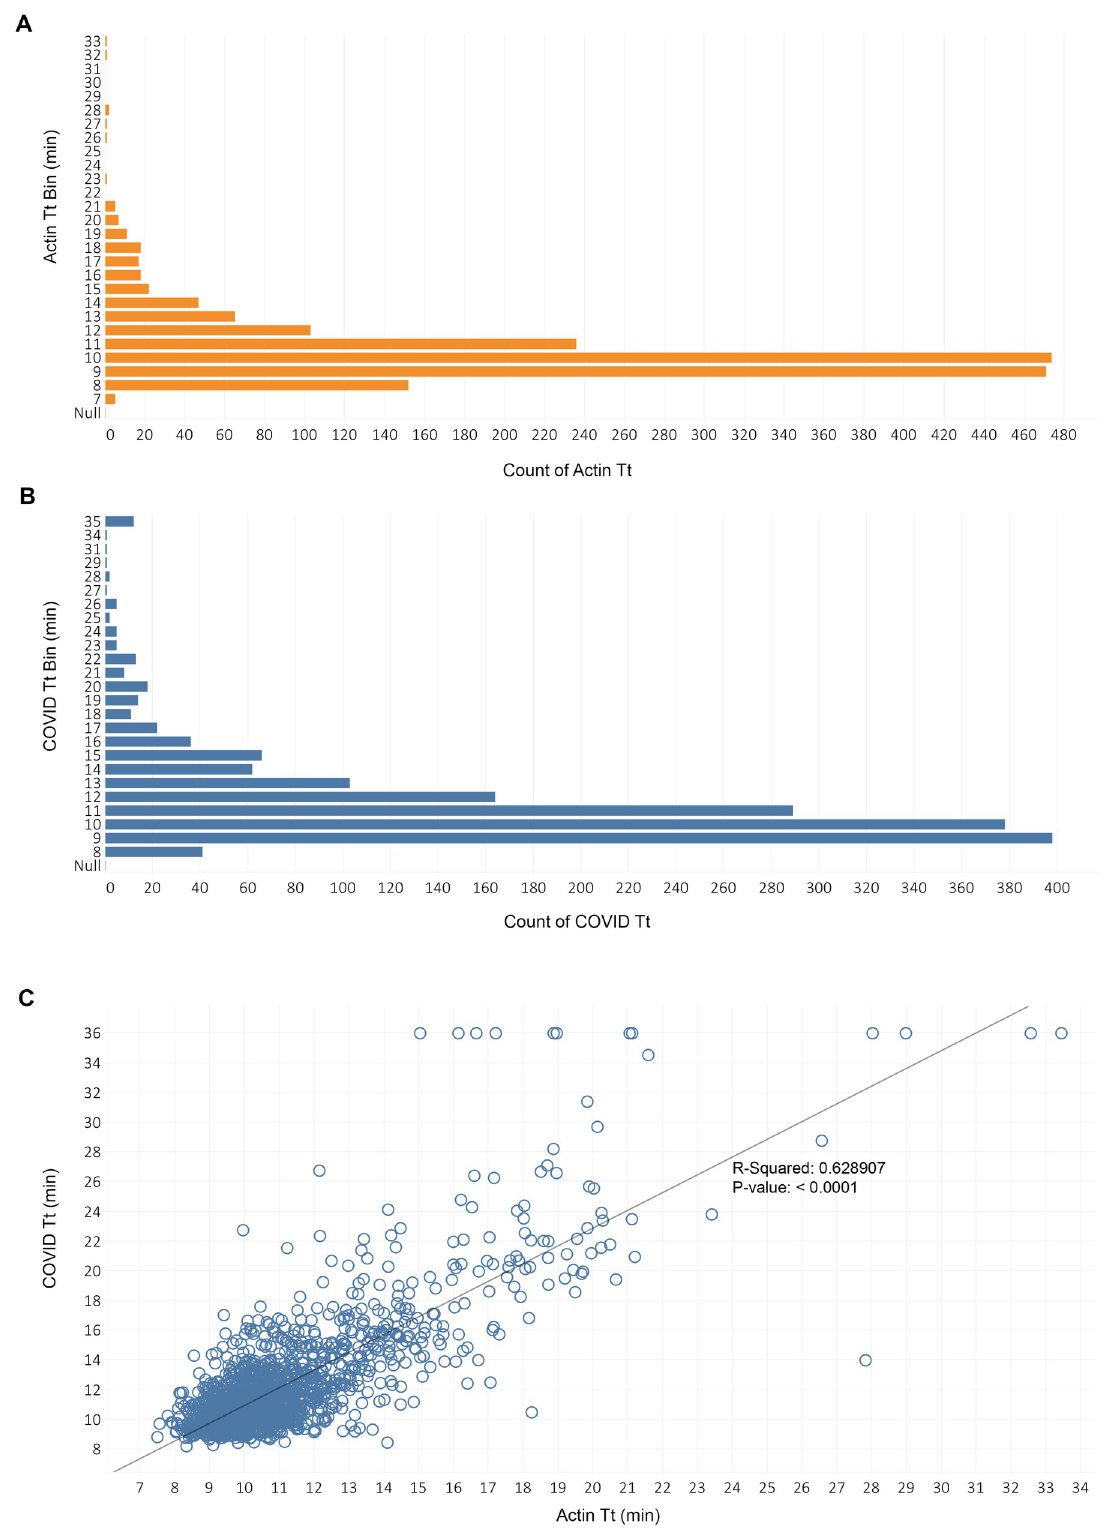
Fig 3. Performance of the extraction-free RT-LAMP method using saliva collected from a large cohort of individuals. A total of 1670 negative saliva samples were each spiked with 50 copies/ μ L of virus and evaluated in COVID and actin LAMP reactions. Histogram